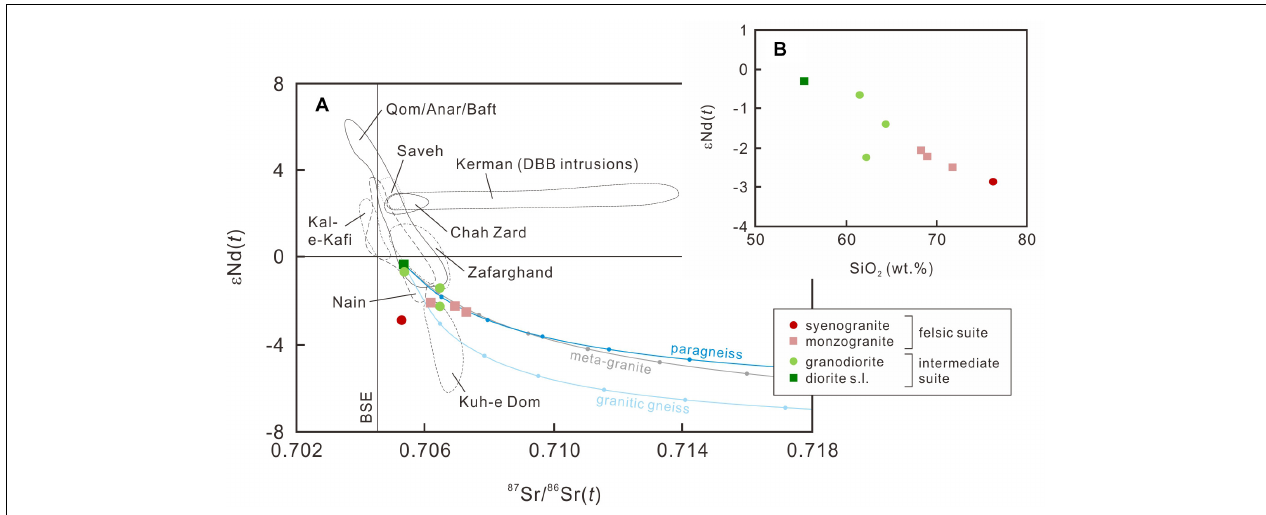
FIGURE 10 | Covariations involving Sr and Nd isotopes for the studied samples. (A) A binary diagram of ε Nd versus 87 Sr/ 86 Sr. (B) A binary diagram of ε Nd versus SiO 2 . Shown in frame (A) are fields of published data obtained from the Urumieh-Dokhtar belt, including Qom/Anar/Baft (Omrani et al., 2008), Kerman (DBB intrusions, Dargahi et al., 2010), Nain (Yeganehfar et al., 2013), Kuh-e Dom (Sarjoughian et al., 2012; Kananian et al., 2014), Kal-e-Kafi (Ahmadian et al., 2016), Chah Zard (Kouhestani et al., 2017), Saveh (Nouri et al., 2018), and Zafarghand (Sarjoughian et al., 2018). Also shown are AFC trajectories assuming sample I-10, which has the lowest 87 Sr/ 86 Sr 25 Ma and ε Nd 25 Ma among the studied samples, underwent concurrent fractional crystallization and assimilation of different crustal rocks from the ChahJam-Biarjmand metamorphic complex, Iran (Shafaii Moghadam et al., 2015): metagranite (sample BJ10-20, gray), paragneiss (sample CHJ09-12, deep blue), and granitic gneiss (sample CHJ09-18, light blue). The trajectories are computed using equations of DePaolo (1981) with the following parameters: crystal-liquid partition coefficients of Sr (2 for plagioclase, 0.096 for clinopyroxene, and 0.0022 for olivine) and Nd (0.14 for plagioclase, 0.173 for clinopyroxene, and 0.001 for olivine) [compiled by Ersoy and Helvacı (2010)], a fractionating assemblage consisting of plagioclase, clinopyroxene and olivine at 6:2:2, and a ratio of assimilation rate to fractional crystallization rate of 0.5. Dots on the trajectories denote 10% intervals for the fraction of remaining